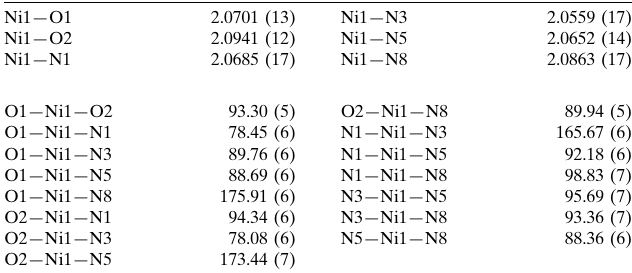
Selected geometric parameters (A˚ , (cid:2) ).